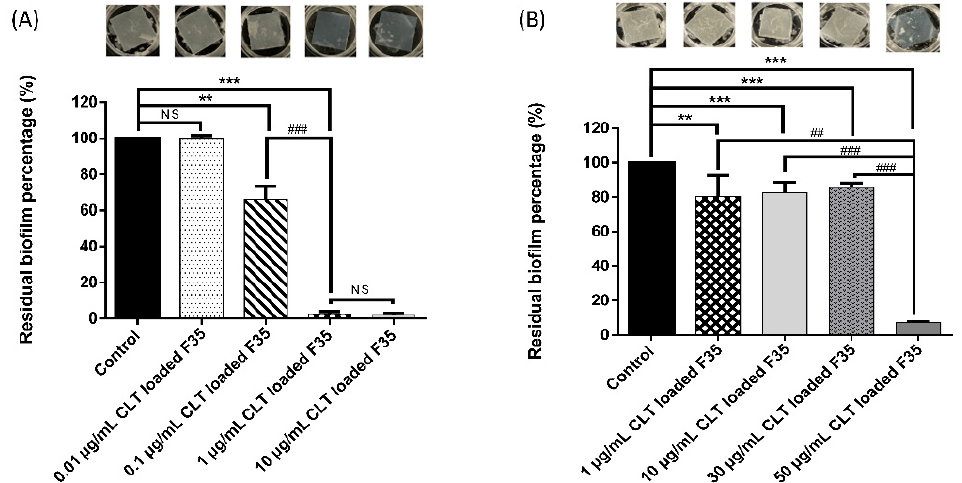
Figure 3. The effect of F35 with different CLT loading doses against C. albicans biofilm. ( A ) The result of C. albicans biofilm formation inhibitory tests by different loading doses of CLT in F35. ( B ) The degree of CLT-F35 causing C. albicans biofilm destruction. Each value represents the mean ± standard deviation from three independent experiments. ** p < 0.01 *** p < 0.001 as compared to F35 without drug. ## p < 0.01 ### p < 0.001 as compared to F35 with 1 μ g/mL CLT loading dose.